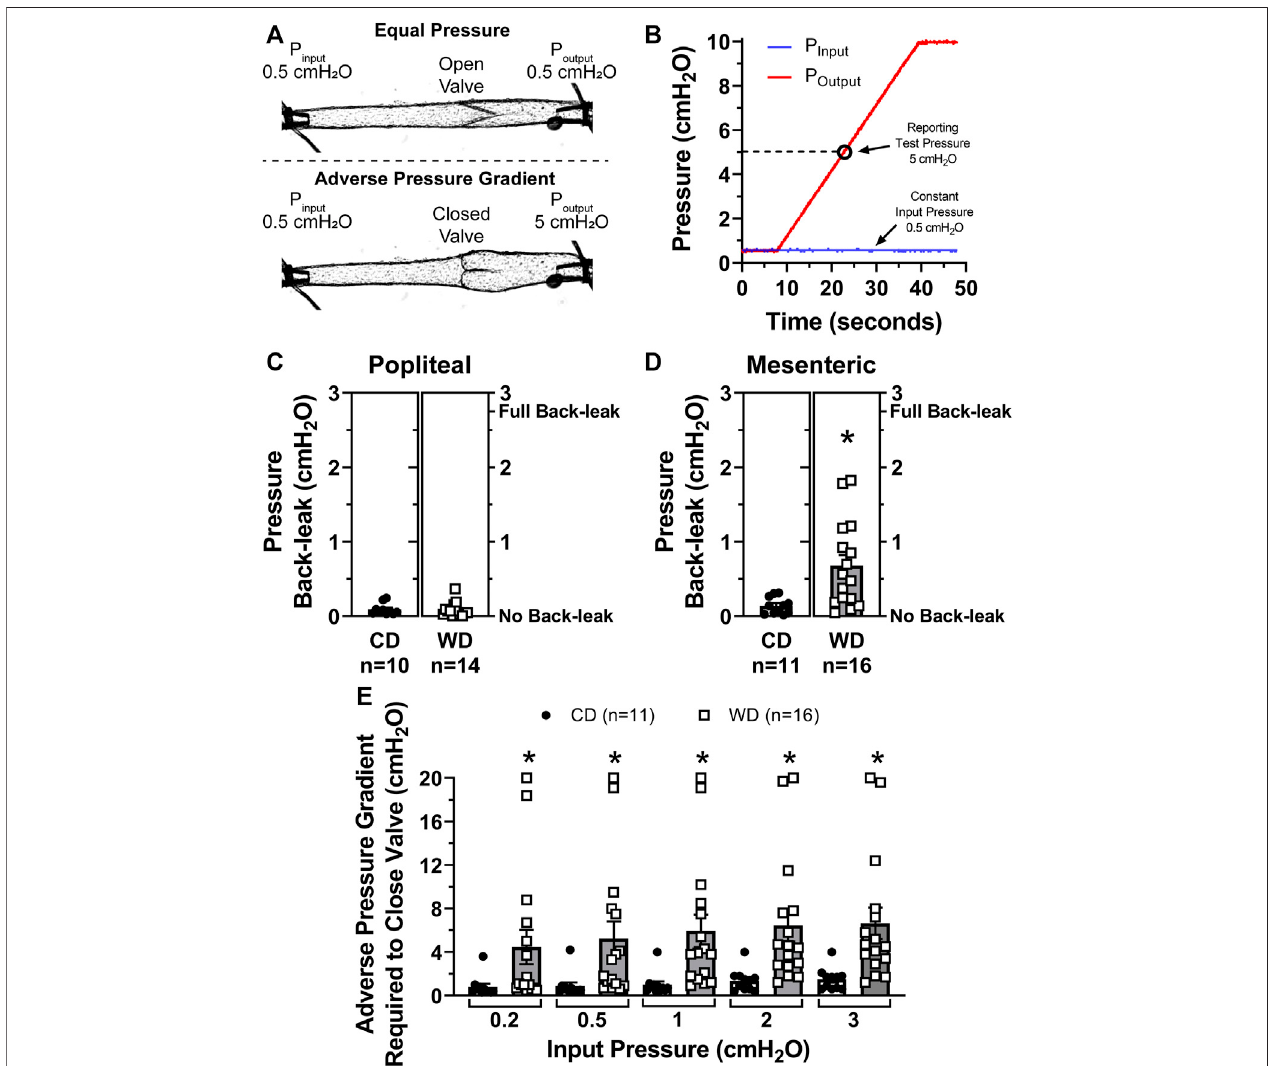
FIGURE 2 | Diet-induced obesity induced valve dysfunction in mesenteric but not popliteal lymphatic vessels. (A) Diagram of a representative valve test displaying the initial state, i.e., P input = P output = 0.5 cmH 2 O (valve open, top), and during valve challenge, i.e., P input = 0.5 and P output = 5 cmH 2 O (valve closed, bottom); (B) representativetracesforP input (blue)andP output (red)pressuresduringavalvetest. Results arereportedwhen P output =5 cmH 2 O(opencircle); (C,D) pressureback-leak measurements comparing CD and WD groups in popliteal and mesenteric lymphatics respectively. Each data point represents each individually tested valve. Multiple tests, i.e., 2-3, were performed on each valve, each data point represents the mean of all these tests; and (E) the adverse pressure gradient required to drive eachspeci fi cvalveontoaclosedpositionwhenP input wassetandmaintainedat5differentintraluminalbaselinepressurelevels(i.e.,0.2,0.5,1,2,and3 cmH 2 O).Datais presented as mean ± SEM. Datasets included in this fi gure were not normally distributed, therefore, statistical differences were evaluated using non-parametric t tests. * p < 0.05 for CD vs.